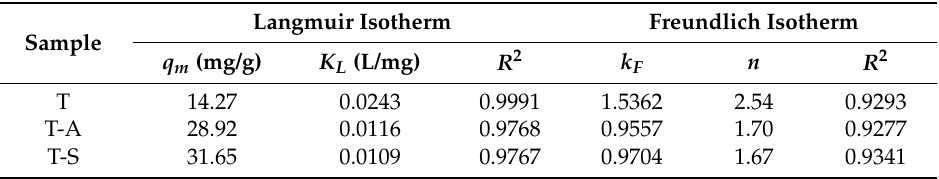
Table 4. Comparison of adsorption ability of Cr(VI) on various absorbents.